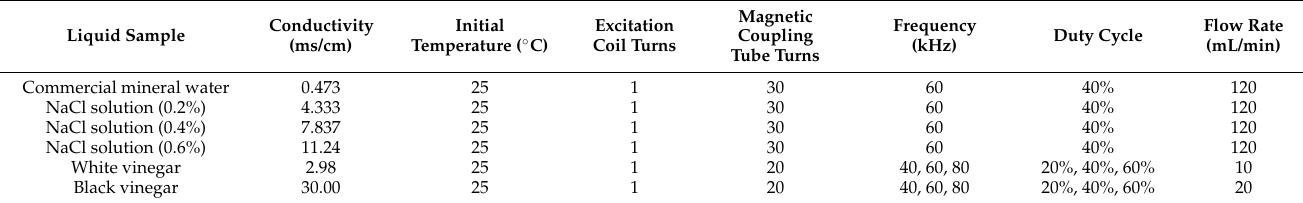
Table 1. Various parameter information during